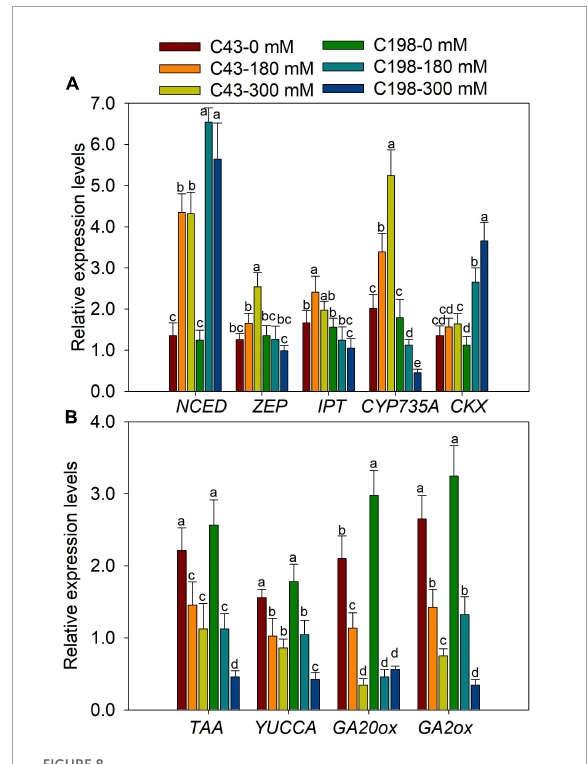
FIGURE8 Gene expression levels in leaves of the two bermudagrass genotypes differing in salt tolerance (C43: tolerant; C198: sensitive). (A) genes related to ABA and cytokinin biosynthesis; (B) genes relate to auxin and GA biosynthesis. Bars marked by the same letters are not significant at P < 0.05 (Tukey’s test) for the comparison of different treatments. Data represent the mean ± SD of four independent biological